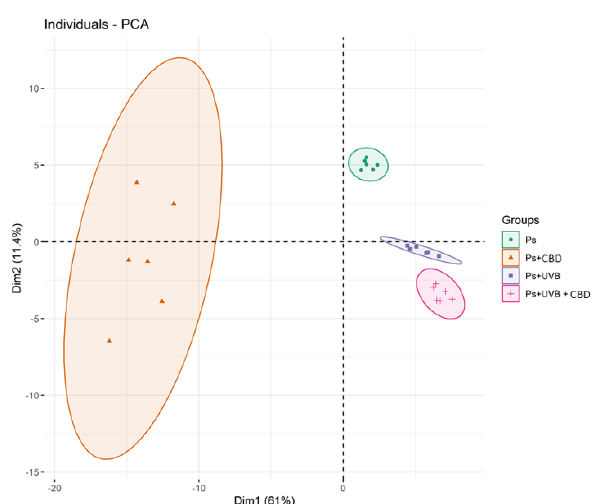
Figure 5. Principal component analysis (PCA) in a two-dimensional score plot of the relative abundance of phospholipid species in keratinocytes, isolated from the skin of psoriatic patients (Ps). These cells were not treated or treated with CBD (4 μM) or/and UVB (60 mJ/cm 2 ). The following groups of keratinocytes were examined: Ps, Ps + CBD, Ps + UVB and Ps + UVB + CBD. All samples were analyzed after 24 h of treatment.